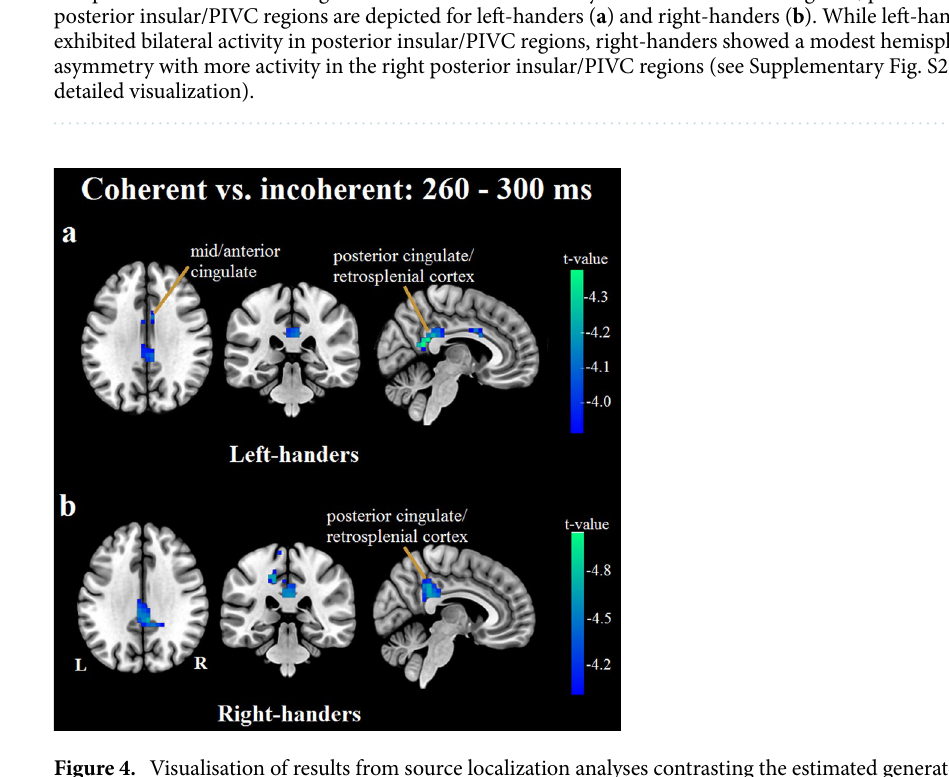
Figure 4. Visualisation of results from source localization analyses contrasting the estimated generators in the coherent versus the incoherent condition in the late (260–300 ms) window. In left-handers ( a ), estimated source activity modulations were observed in the posterior cingulate/retrosplenial cortex/precuneus, and the mid/anterior cingulate. In right-handers, estimated source activity modulations were identified in the posterior cingulate/retrosplenial cortex/precuneus, superior parietal lobule, pre- and post-central gyri, and (left) parieto- operculum/insular cortex. ( b ) Depicts the estimated source activity differences in the posterior cingulate/ retrosplenial cortex/precuneus observed in